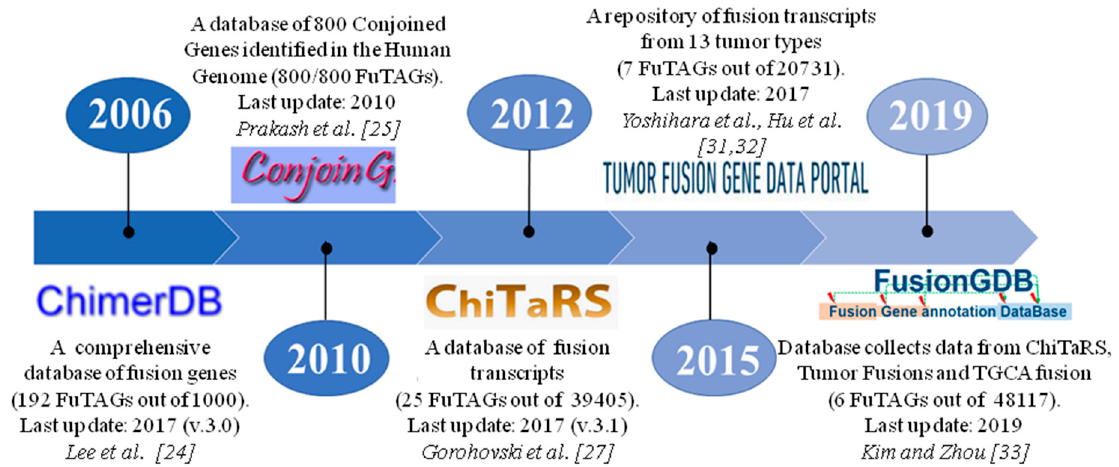
Figure 2. The timeline of five public databases collecting FuTAGs reports the year of publication, last update and number of FuTAGs compared to total